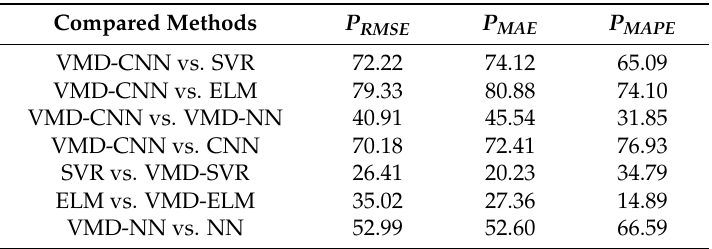
Table 4. Improved percentages of different methods in multi-step forecasting.